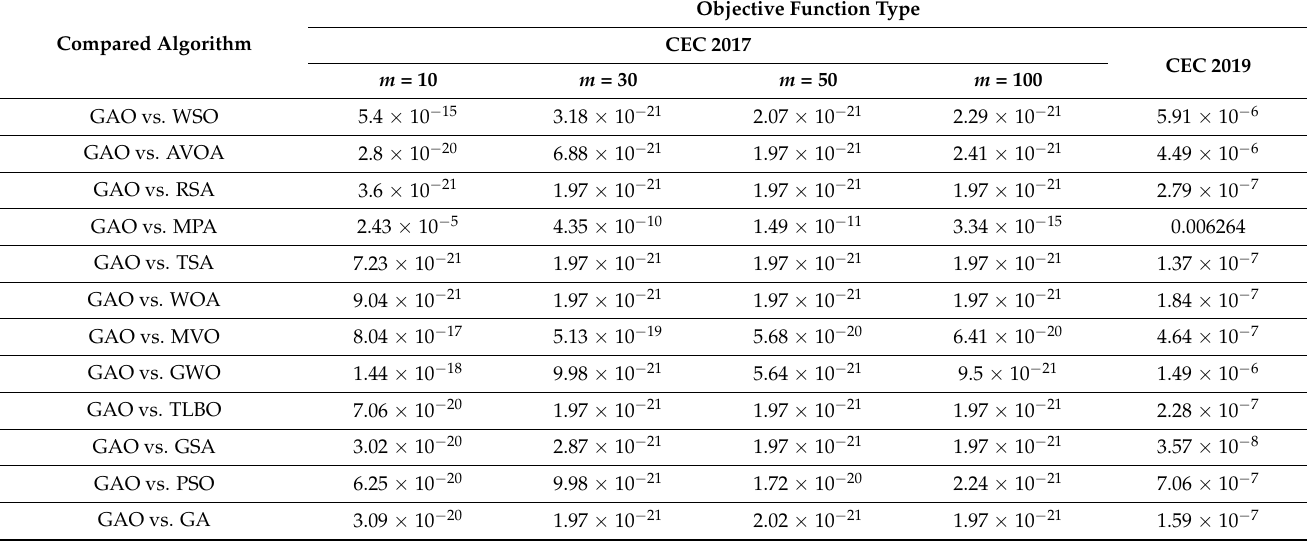
Table 7. Wilcoxon rank sum test